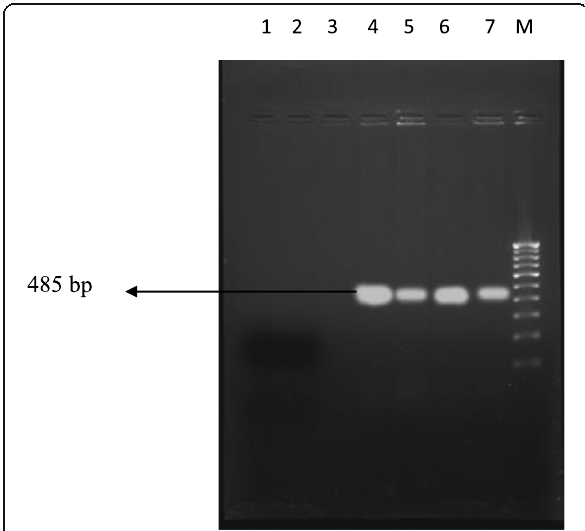
Fig. 7 PCR result showing production of IFN- γ in MG-fed birds and control group. Lane 1, negative control; lane 2 and 3, PBMC and iIEL of control group of birds; lane 4 and 5, PBMC and iIEL of group A bird; lane 6 and 7, PBMC and iIEL of group B bird; and lane M, 100 bp DNA